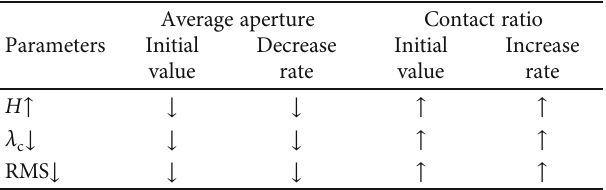
Table 7: Conclusions for the SLS model simulation.